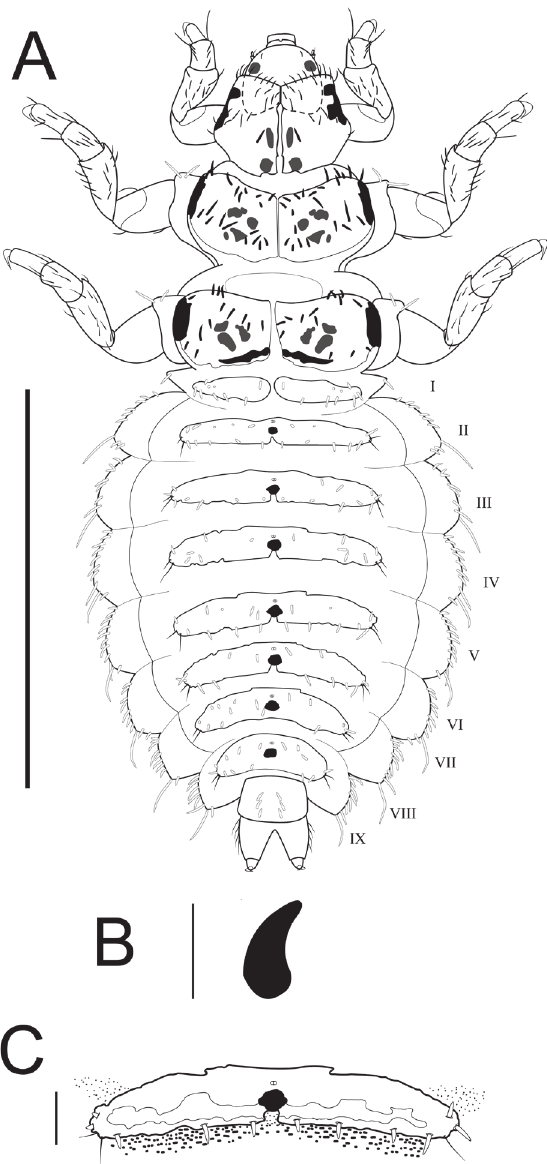
Figure 4. Larva of Mejicanotrichia tridentata (Bueno-Soria & Hamilton, 1986) A habitus, dorsal B pro- pleural sclerite C tergite of abdominal segment V, dorsal. Scale bars: 1 mm ( A ); 65 µm ( B ); 80 µm ( C